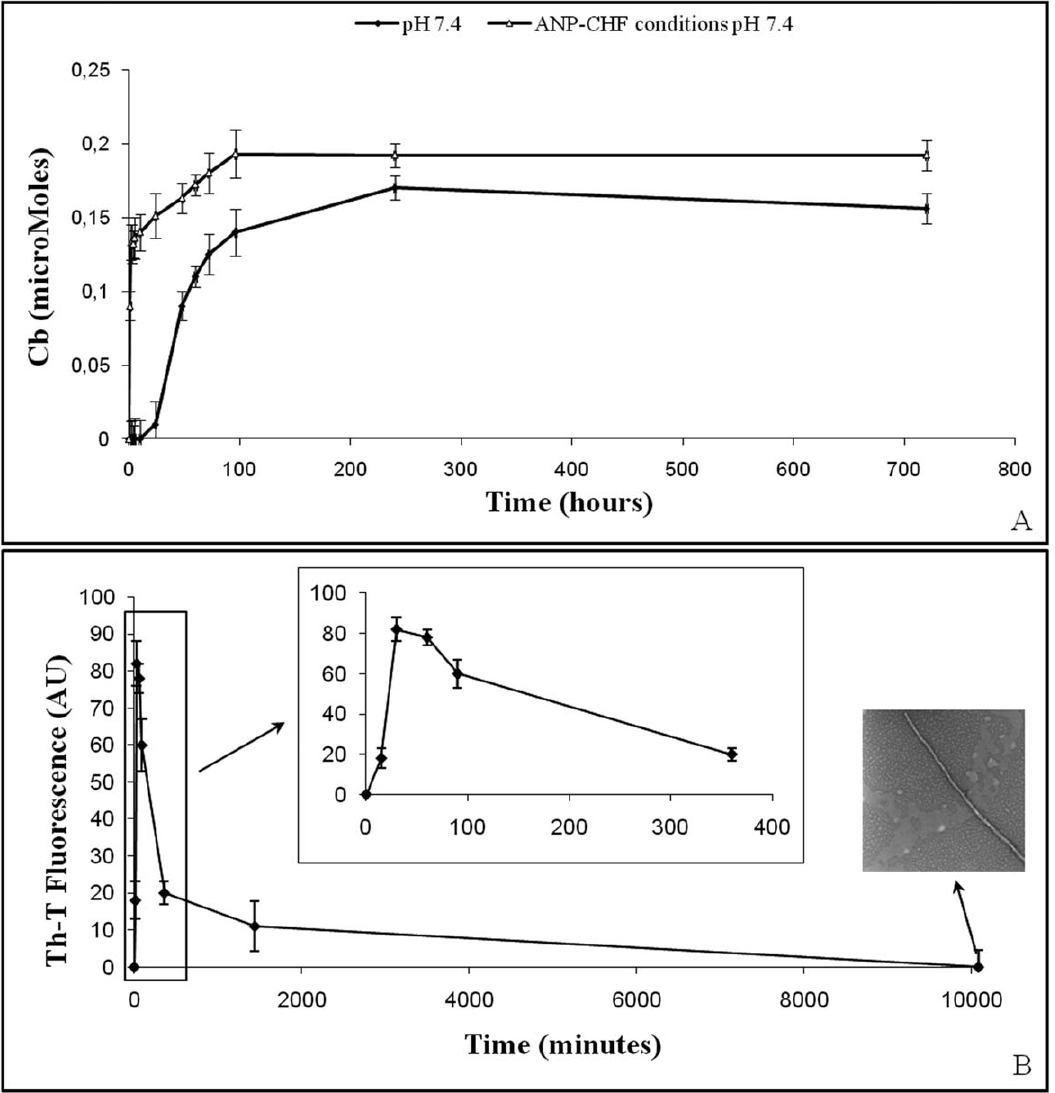
Figure 4. Time course of ANP-CHF fibril formation. A ) Cb and B ) Th-T fluorescence . TEM image after 30 days showed amyloid fibril larger in cross sectional area and longer in length than fibrils formed in all other conditions tested.